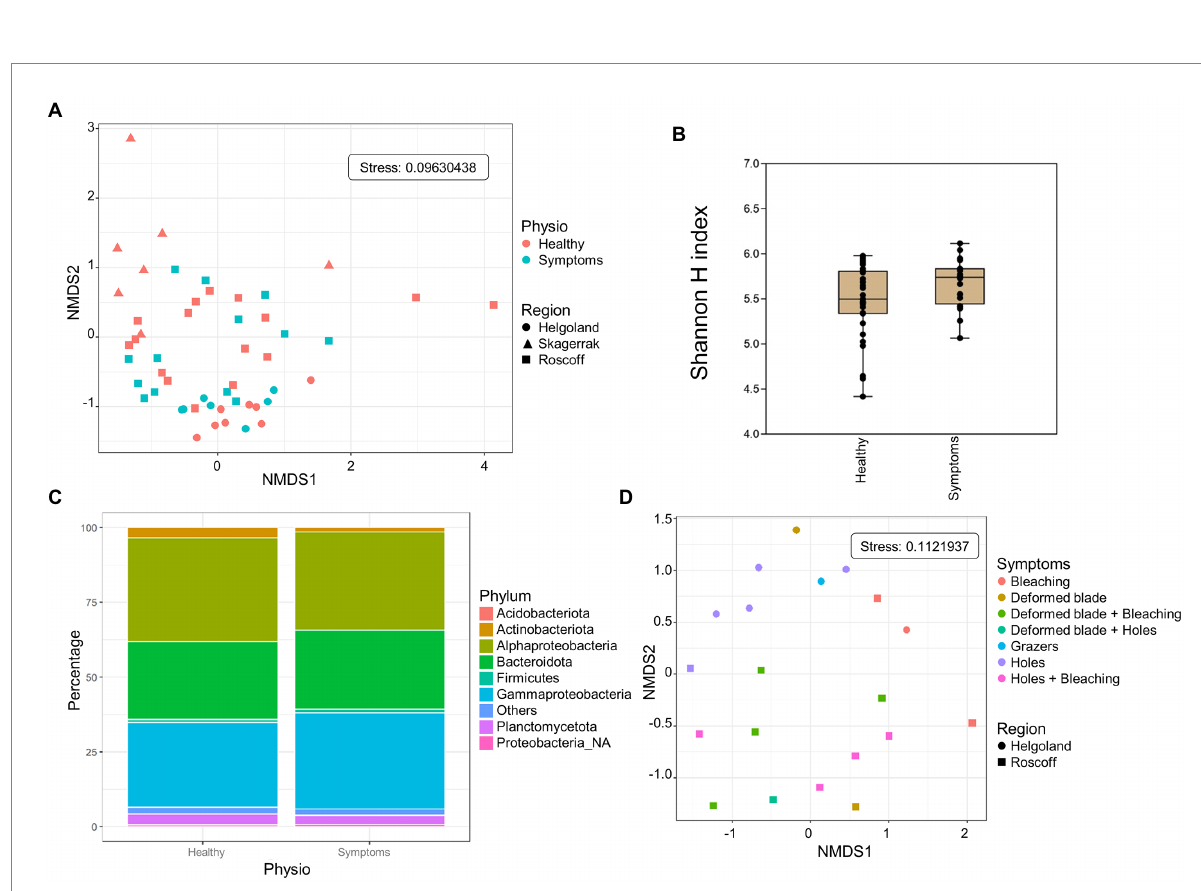
FIGURE 6 Analysis of samples with symptoms from Roscoff and Helgoland. (A) NMDS analysis of the microbiome composition. Results do not show a separation of the healthy and symptomatic samples (PERMANOVA p > 0.05). (B) Box plot of alpha-diversity (Shannon H index) across different sample types calculated at the ASV level. Error bars correspond to the range; n = 51, conditions do not differ significantly (Mann–Whitney pairwise test, p > 0.05). (C) Microbiome composition of healthy and symptoms samples at the phylum level. Bars show the relative abundance of 16S rRNA gene metabarcoding sequences; all phyla were detected in all sample types, and only their relative abundance varied. Proteobacteria_NA : unclassified Proteobacteria. (D) NMDS analysis of the microbiome composition depending on the